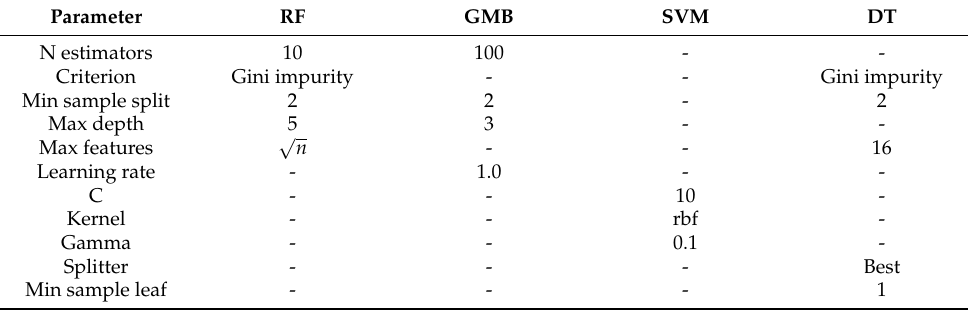
Table 4. Parameters of the centralized models.